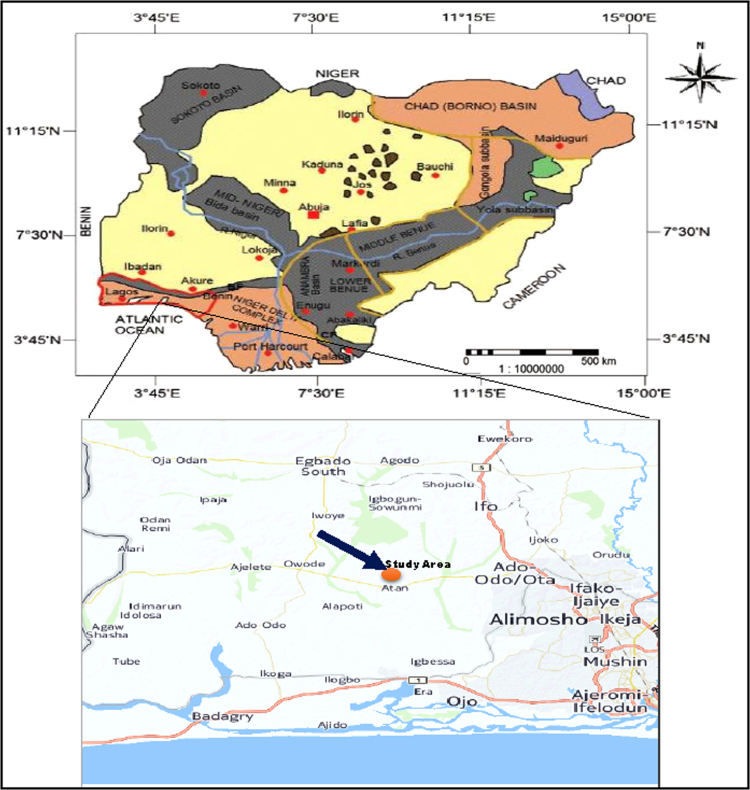
Map of Nigeria with arrow showing plant collection site.